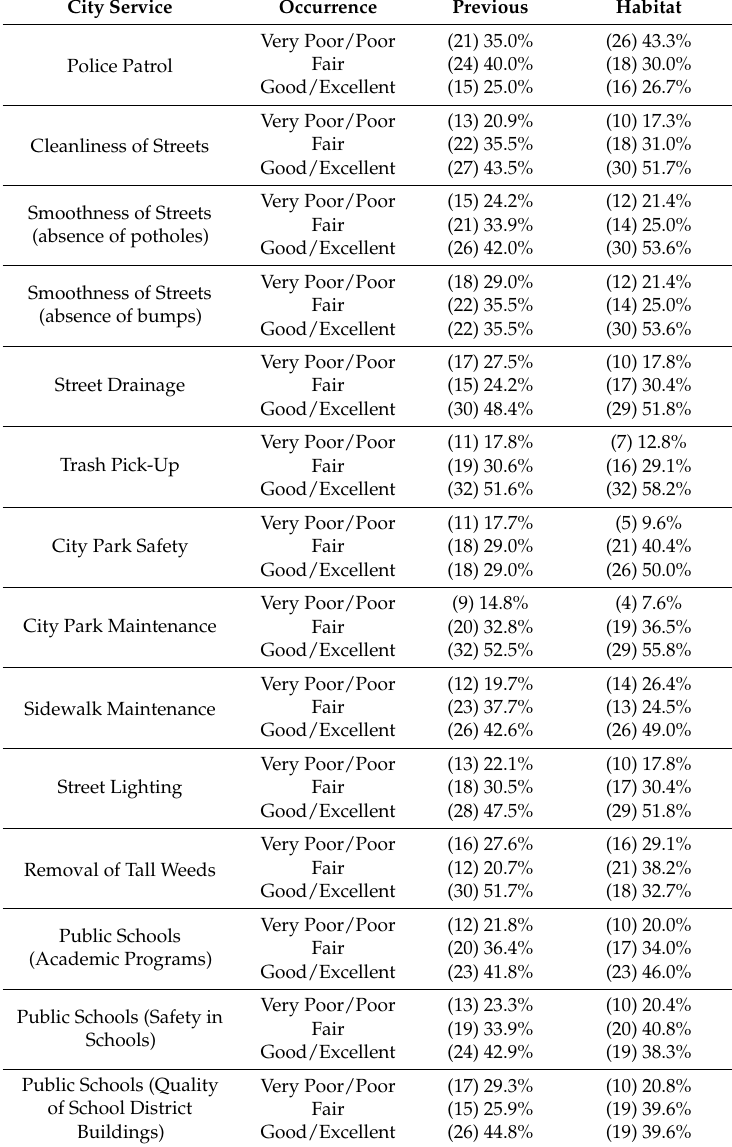
Table 8. Perceptions of Respondents Regarding Quality of City Services in Their “Previous” and “Habitat”